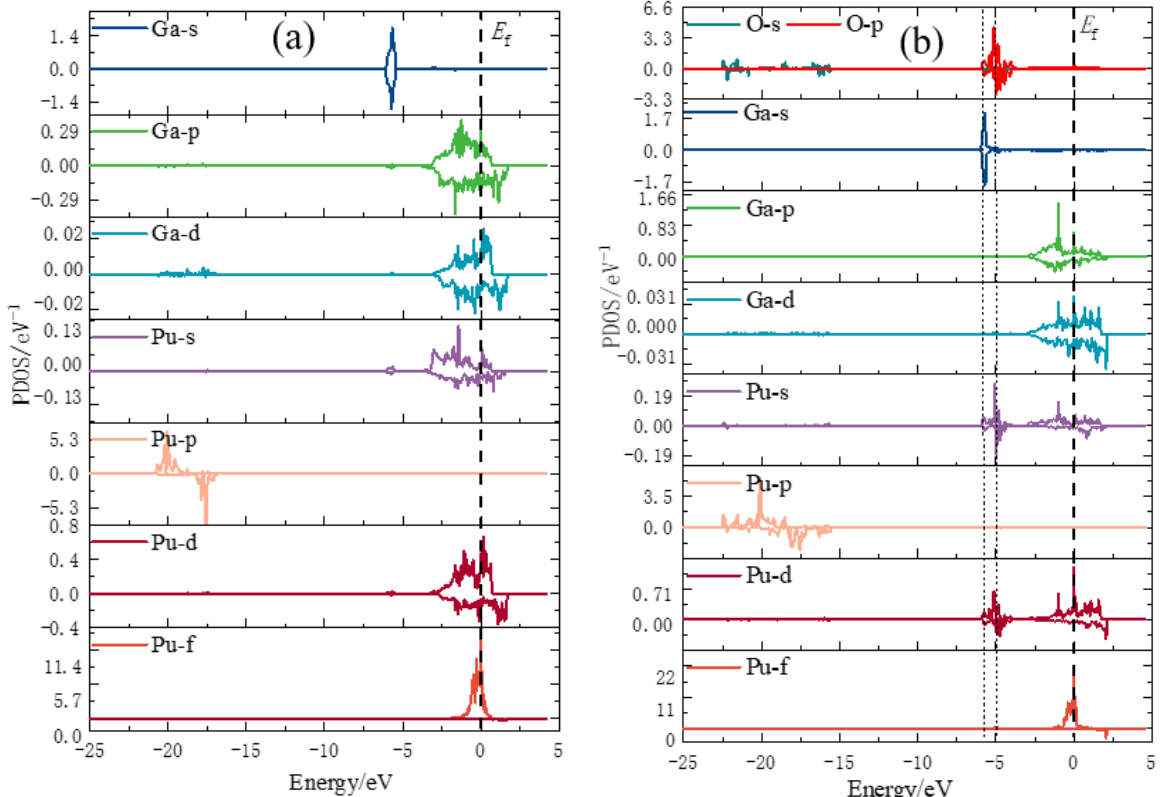
Figure 6. Fractional density of oxygen molecules after adsorption on the surface of plutonium gallium system: ( a ) fractional density of pure surfaces; ( b ) fractional density of oxygen after adsorption.